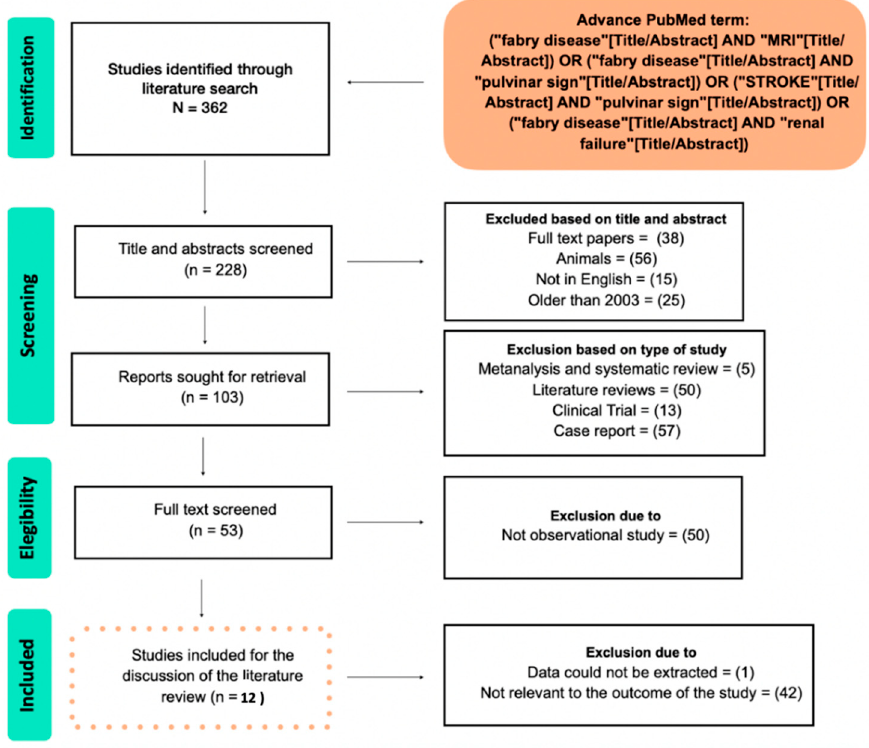
Figure 1. Flowchart of the study.